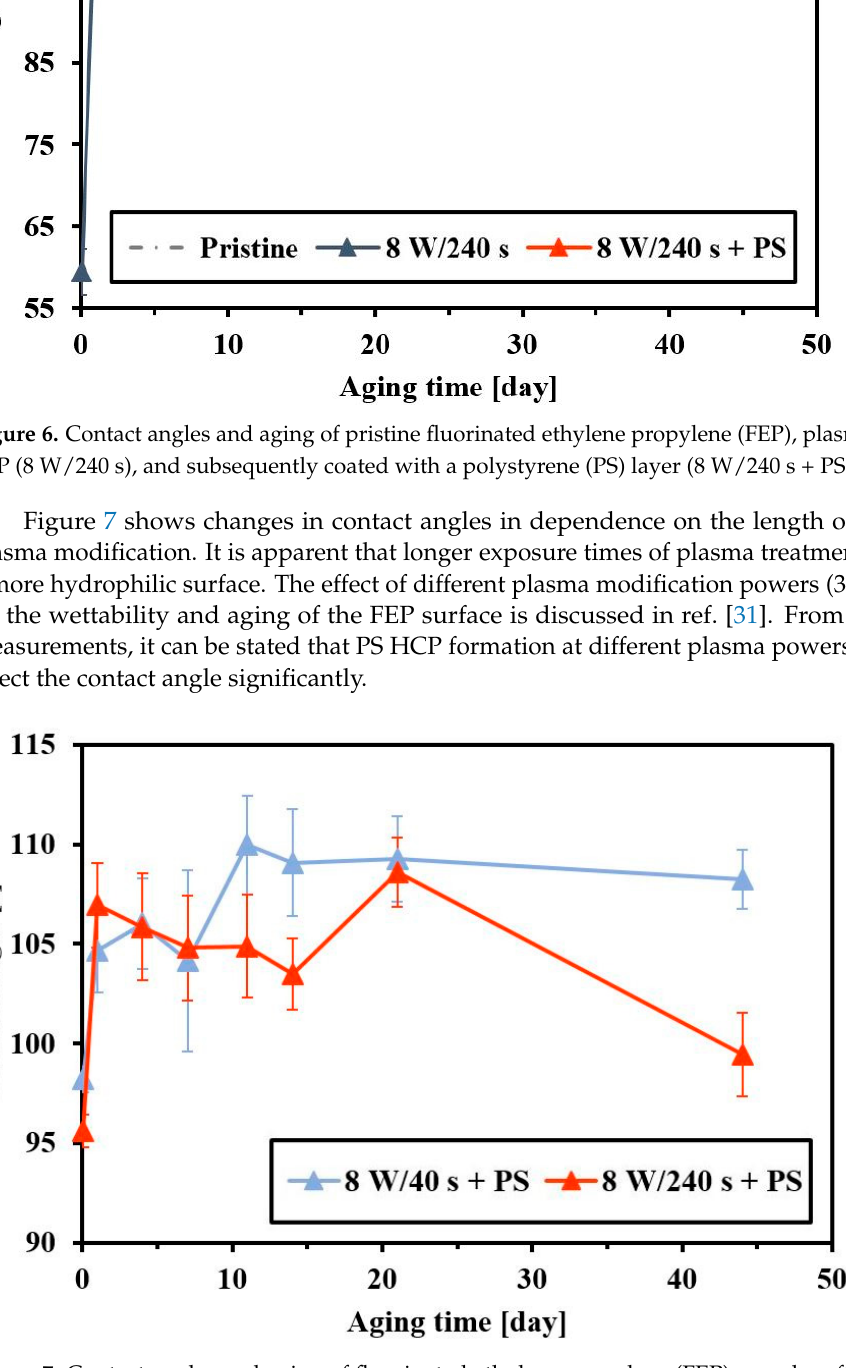
Figure 7. Contact angles and aging of fluorinated ethylene propylene (FEP) samples after plasma modification (8 W) and subsequently coated with a polystyrene (PS) layer in dependence on plasma exposure time (40 s and 240 s).